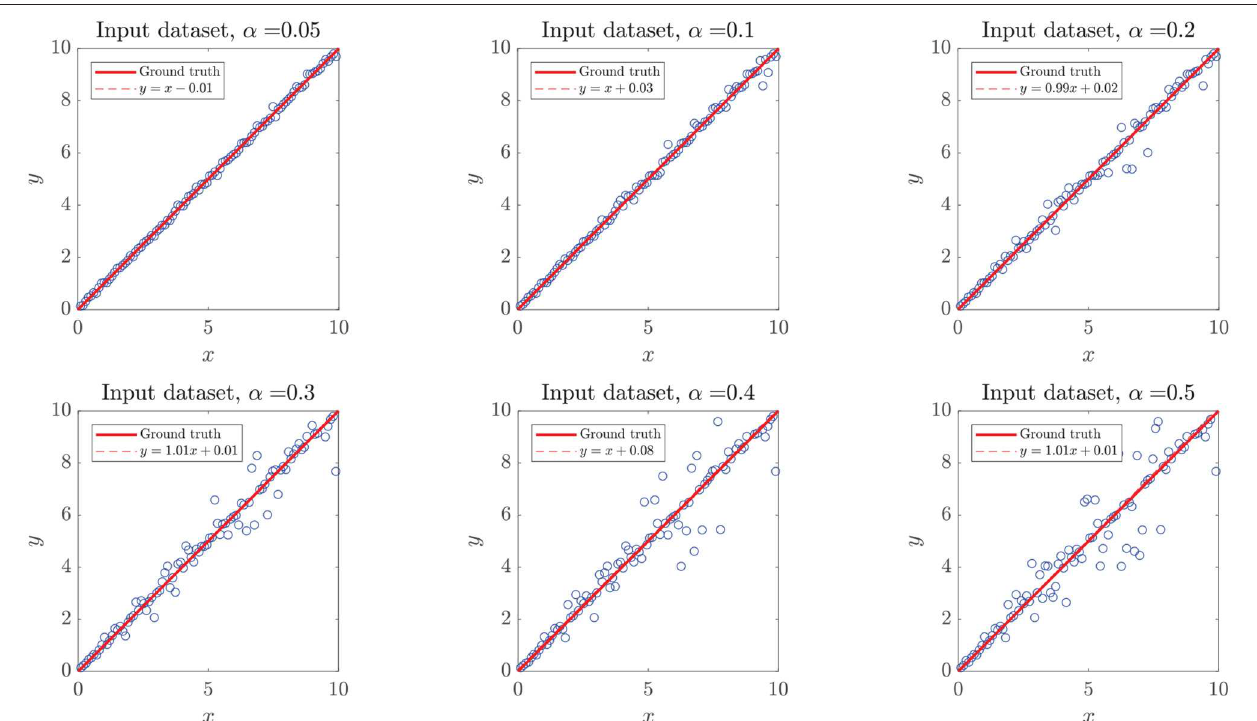
FIGURE 6 | Simulated dataset with added white noise α . The plots represent simulated (y) vs. ground truth (x) data points (circles), the identity line (continuous line), and the crude statistical regression of the resulting dataset (discontinuous line). Added noise followed a Gaussian distribution around the expected value y = x , not affecting the expected value of the distribution, which translates to regression lines very similar to the